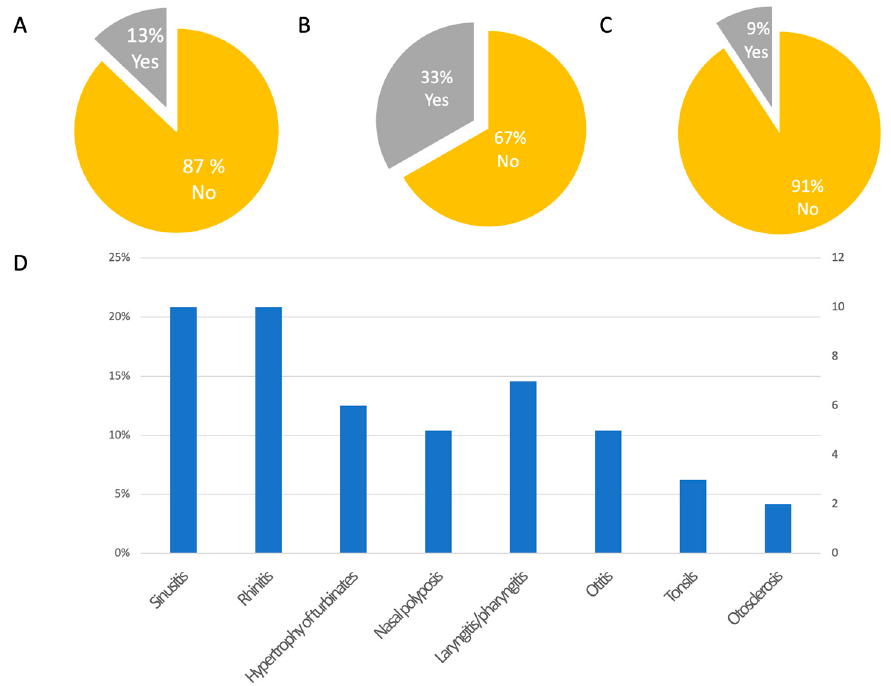
Figure 3. Other epidemiological features. ( A ) Percentage of participants with family history of M é ni è re’s disease; ( B ) Percentage of participants with comorbid allergies; ( C ) Percentage of partici- pants with other otolaryngological disorders; ( D ) Type of associated otolaryngological